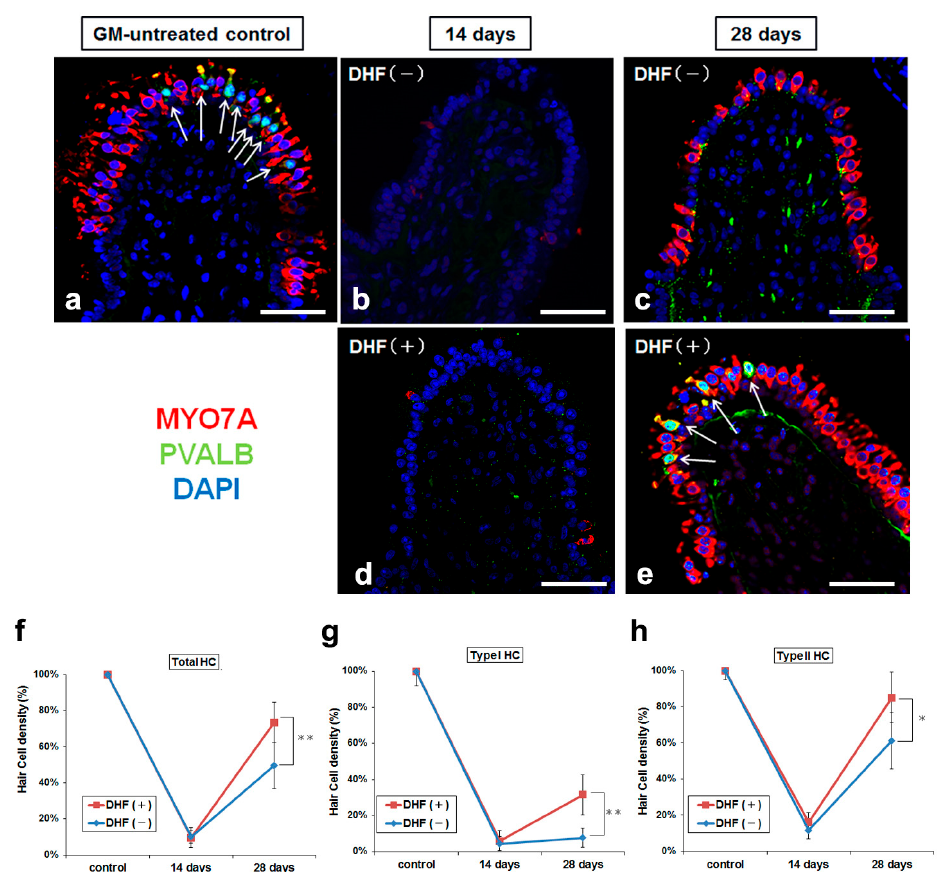
Figure 2. Changes in HC densities. ( a – e ) Confocal images of crista ampullaris stained with MYO7A antibody (red), PVALB antibody (green), and DAPI (blue). ( a ) GM-untreated control shows abundant HCs in the sensory epithelium and many type I HCs, double-stained with MYO7A and PVALB (arrow). ( b , d ) The HCs are remarkably decreased in both DHF ( − ) and DHF (+) groups 14 days after GM treatment. ( c , e ) The HCs are recovered in both groups 28 days after GM treatment. There are some type I HCs in DHF (+) group. ( f – h ) Changes in the densities of total HCs, type I HCs, and type II HCs after GM treatment with/without orally administered DHF (N = 5 for control, DHF (+) and DHF ( − ) at 14 and 28 days). Type I HCs almost disappeared in both groups 14 days after GM treatment, whereas type Ⅱ HCs decreased in both groups. Both types I and II HCs are significantly increased in the DHF (+) group than in the DHF ( − ) group. Scale bar ( a – e ), 50 µm; DAPI, 4 ′ , 6-diamino-2-phenylindole; DHF, 7, 8–Dihydroxyflavone; GM, gentamicin; HC, hair cell; MYO7A, myosin 7a; PVALB, parvalbumin; ** p < 0.01; * p < 0.05 (Mann-Whitney U